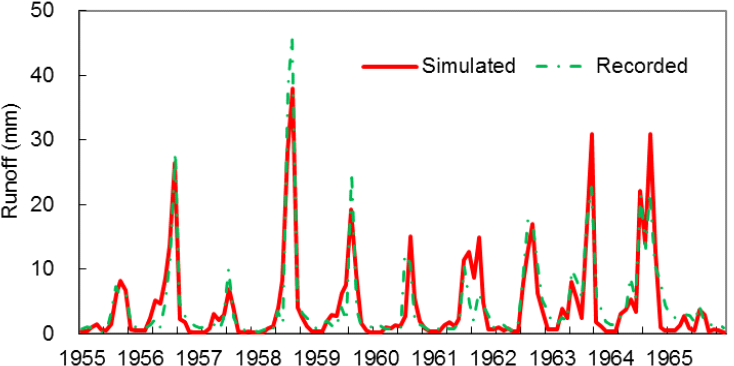
Figure 4. Monthly recorded and simulated runoff at the Daning station for 1955–1965.